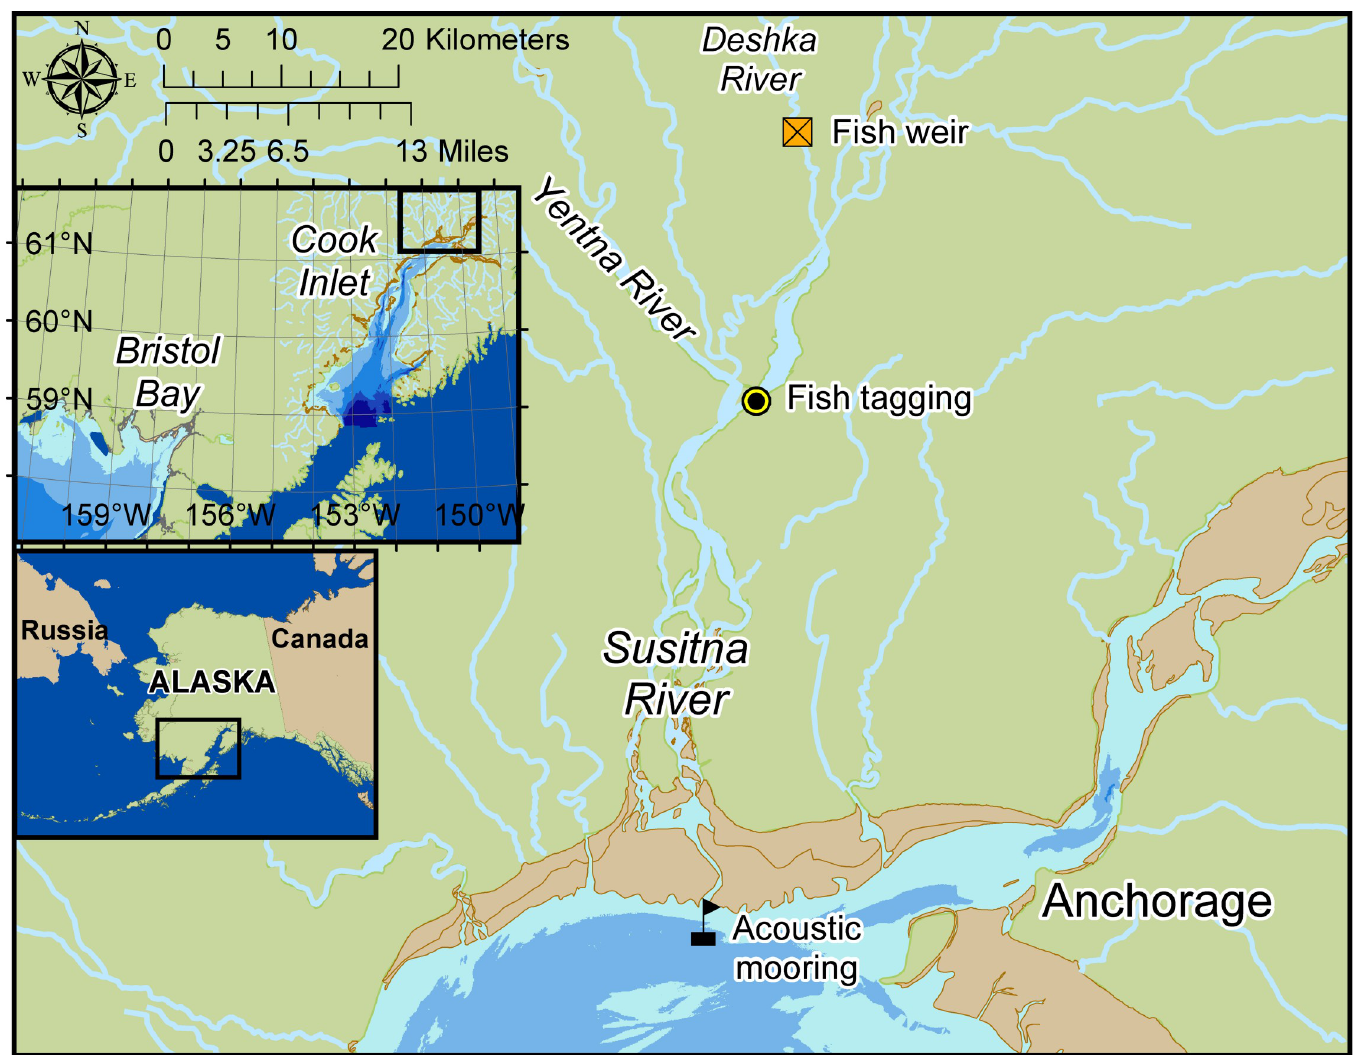
Fig 4. Map of upper Cook Inlet, depicting acoustic mooring location (black flag), fish tagging site and weir (circle and yellow box) at Deshka River (tributary of Susitna River). The map shows mud flats in brown (exposed at low tide), and 20-m depth contour (light to dark blue contour).